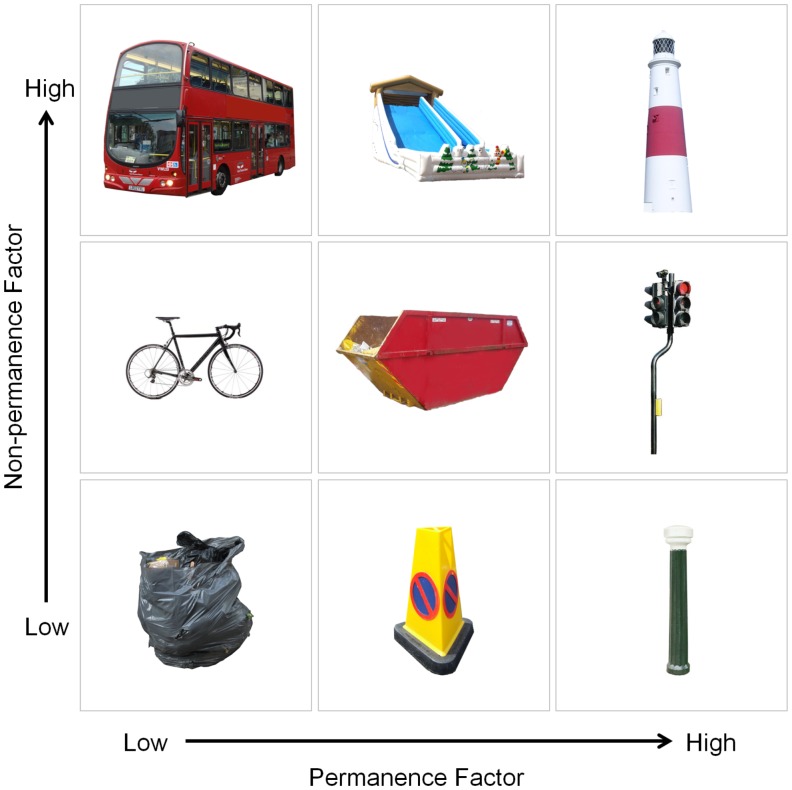
Examples of the stimuli.Example items are shown from the 280 stimuli used in the fMRI study. Level of permanence (from low to high) is shown from left to right. Shown vertically from bottom to top, variation (from low to high) in terms of the non-permanence factor. For further examples of the stimuli see Figure S2.